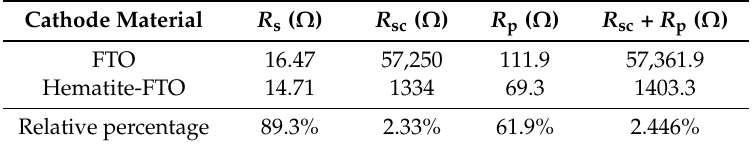
Table 2. Resistance fitting parameters of hematite-FTO (Fluorine-doped tin oxide) and FTO electrodes. Cathode Material Cathode